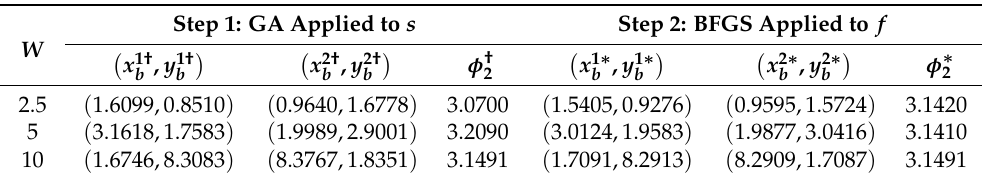
Table 6. The maximizers found by the hybrid method for the case of a pair of helices and three sizes of the flow meter (7): W = 2.5, 5, and